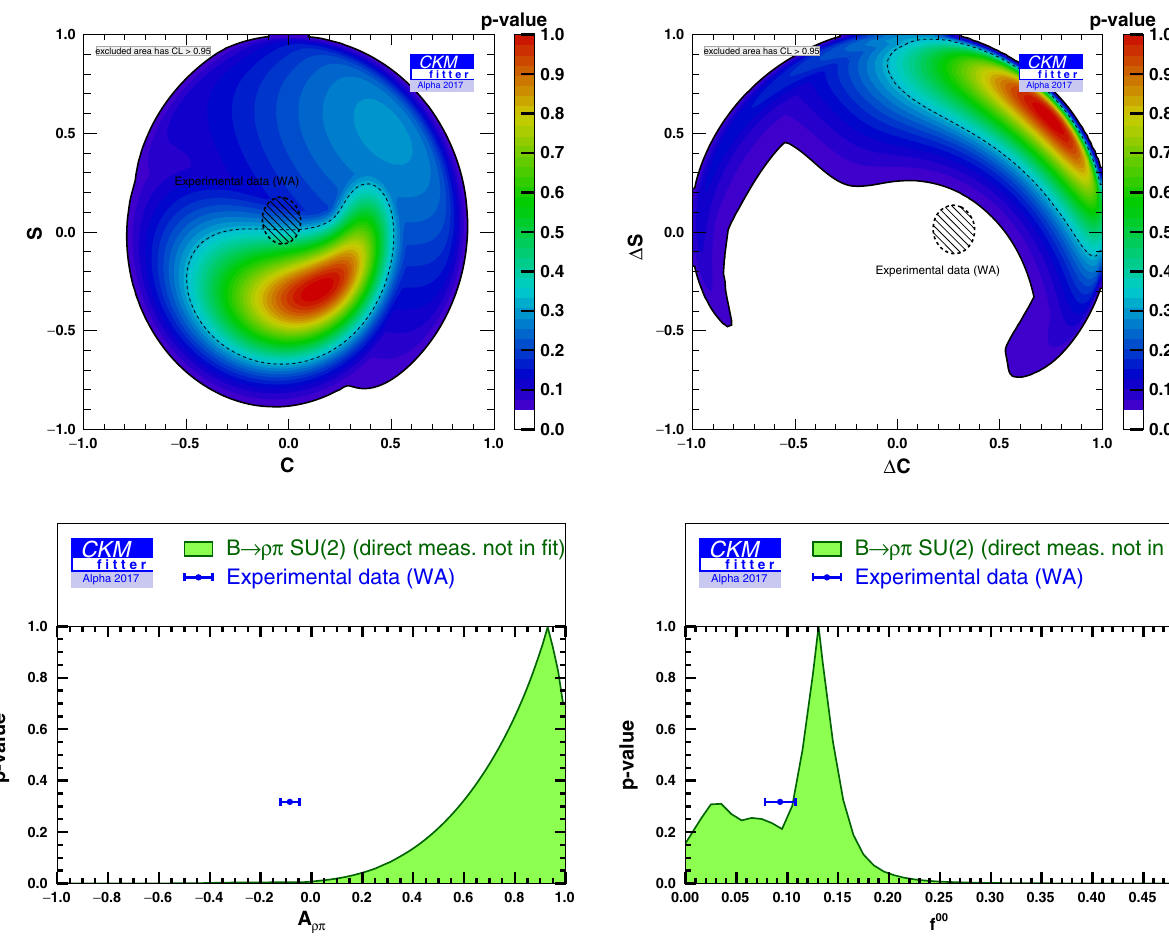
ing fraction f 00 ( bottom ). In each case, the corresponding experimental value derived from the related U or I coefficients, not included in each individual fit, is indicated either by a shaded area or an interval with a dot